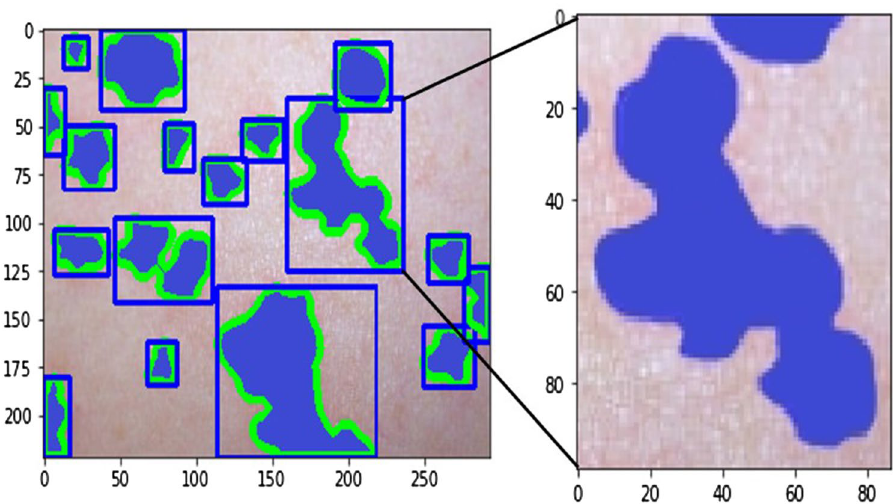
Figure 9. Contour finding algorithm applied to output of U-Net. Clusters of abnormal skin are identified through a contour finding algorithm. Each cluster is cropped in the shape of a rectangle through a convex hull algorithm used to surround each